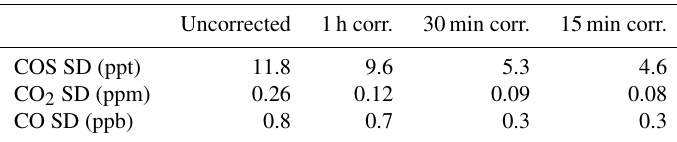
Table 3. Standard deviation (SD) over minute-averaged data of COS, CO 2 and CO over the 19h measurement period for different correction frequencies using reference